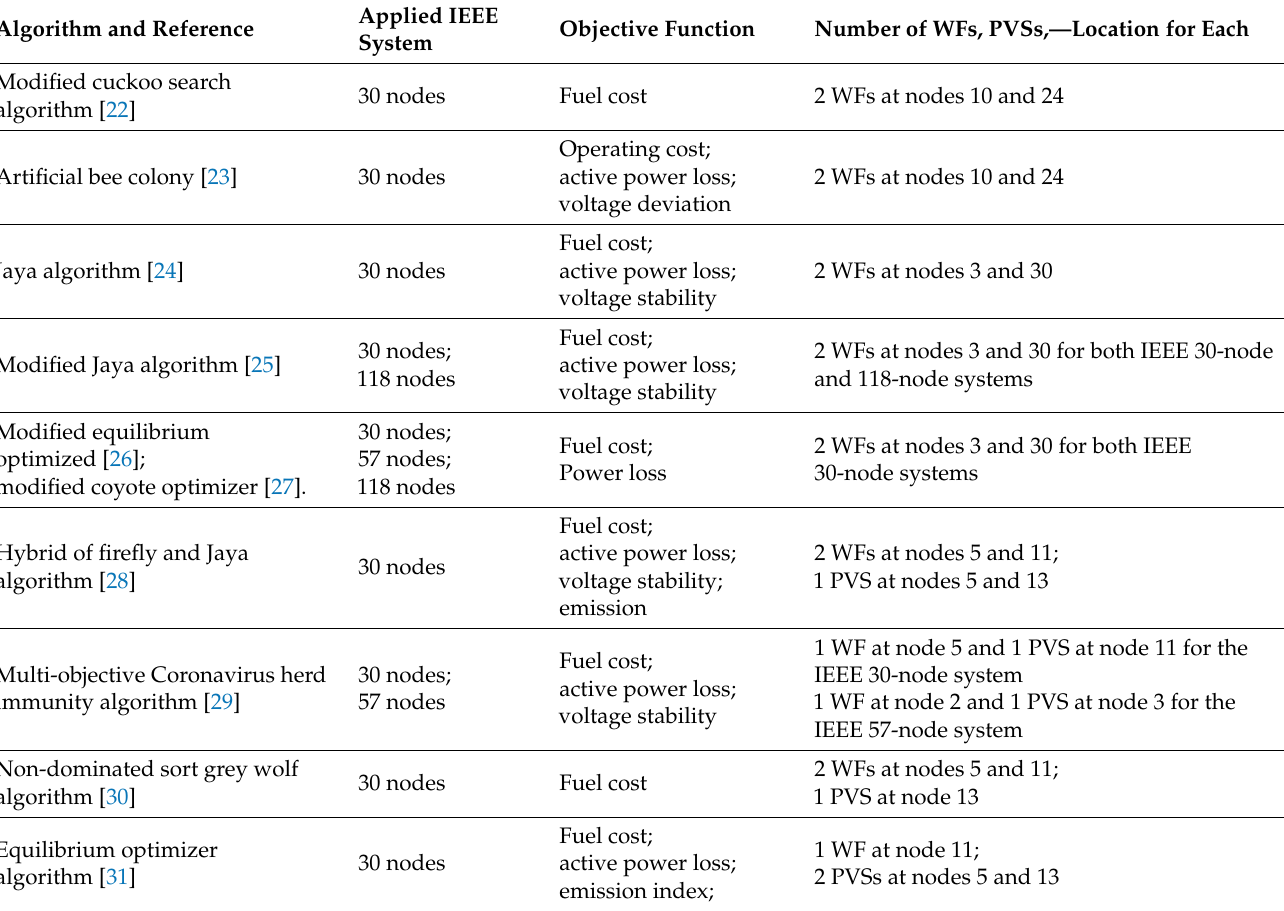
Table 1. The summary of previous studies on solving OPF problems considering renewable energy